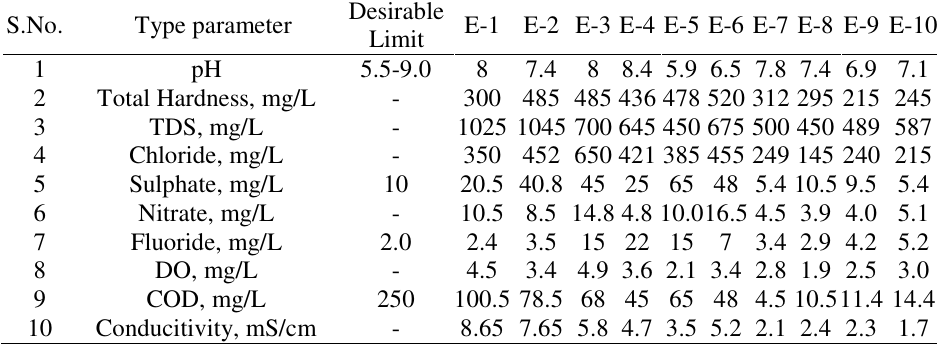
Table 3. The results of physicochemical studies for the effluent water